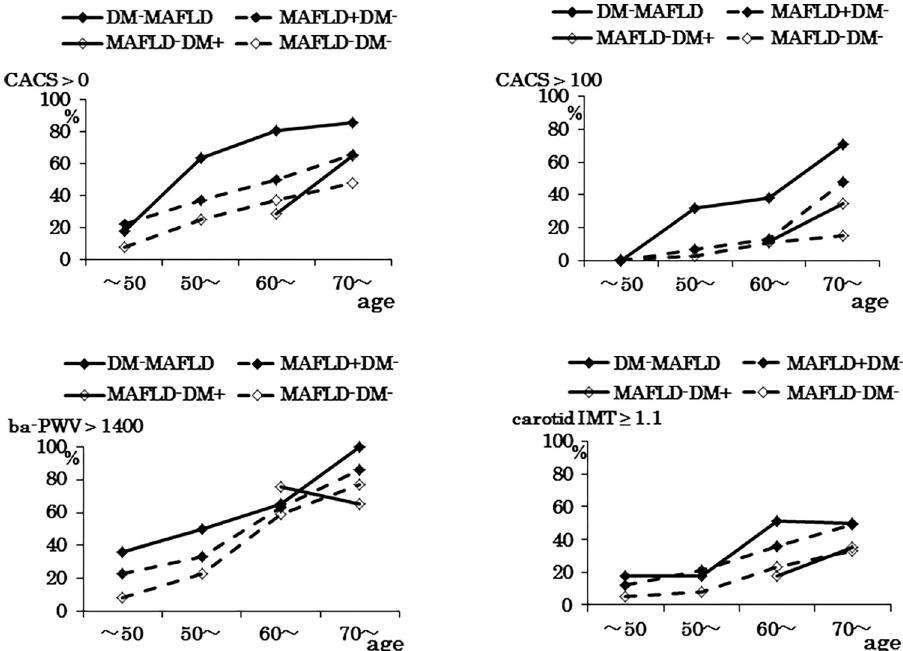
some previous epidemiological studies [17, 22, 23]. In the comparison of MAFLD but without NAFLD (MAFLD only) to NAFLD (S1 Table), the former was predominantly male, with a higher proportion of drinkers or smokers, and a higher frequency of metabolic disorders such as hypertension or diabetes. This difference is believed to be due to differences in the diagnos- tic criteria for MAFLD and NAFLD. The proportion of coexisting DM with MAFLD (i.e., DM-MAFLD) among MAFLD in this study was slightly higher than in previous reports [17,